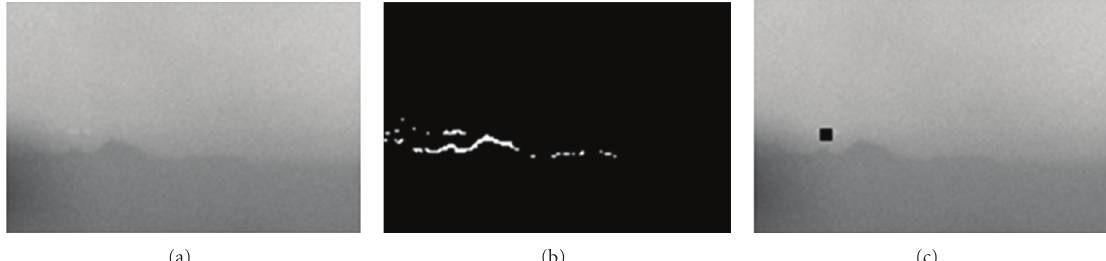
Figure 11: (a) Search window enclosing horizon; (b) edge detection-labeling implementation; (c) image processing algorithm output.